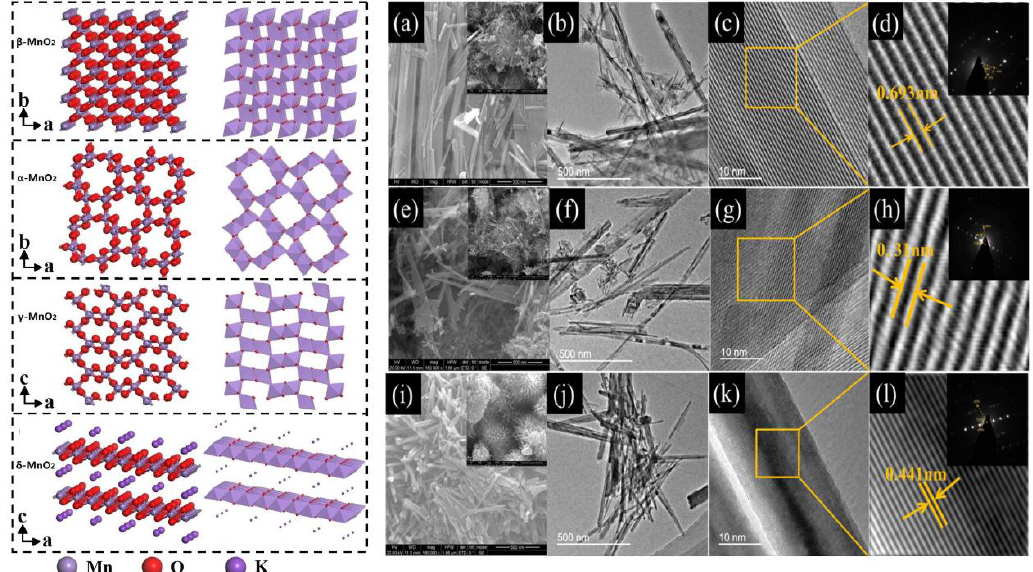
Figure 2. Crystal structure of β - , α - , γ -, and δ -MnO 2 [23]. SEM and TEM images of α -MnO 2 -110 ( a – d ), α -MnO 2 -310 ( e – h ), and α -MnO 2 -210 ( i – l ) [24]. Copyright 2019 and 2021, Elsevier B.V. Table 1. Catalytic activity for toluene combustion over single metal oxides reported in the recent literature.